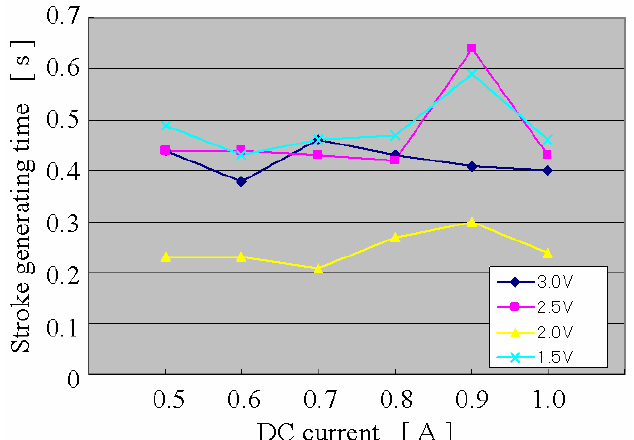
Figure 9. Stroke generating times of SMA coil spring transducer for applied sets of DC voltage and